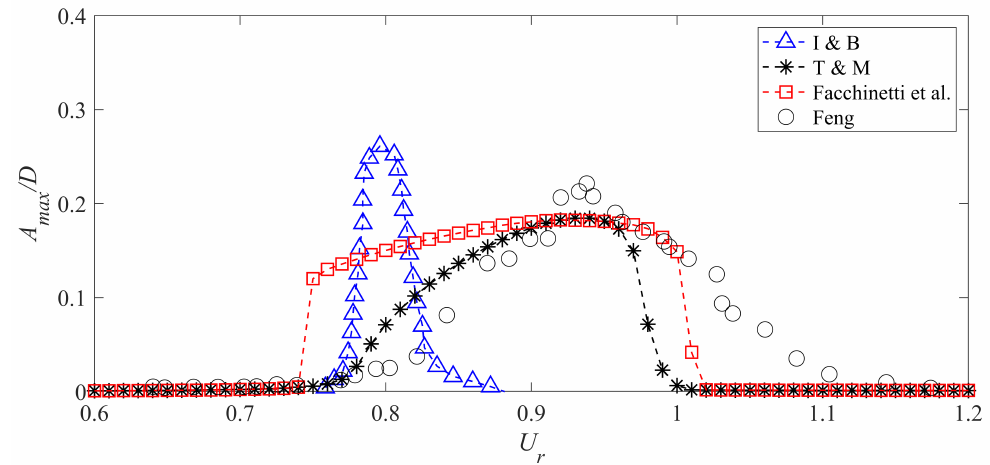
Figure 5. Comparison of predictions of the maximum oscillation amplitude A max as a function of the reduced velocity U r of the VIV of a circular cylinder with diameter D obtained using three mathematical models with a benchmark experiment conducted by Feng [52], Iwan and Blevins [41] (I&B), Tamura and Matsui [39] (T&M) and Facchinetti et al.